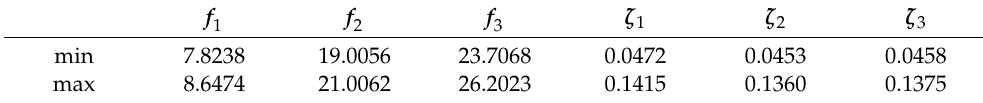
Table 1. Minimum and maximum values of frequencies and damping ratios for the 3DoF case.